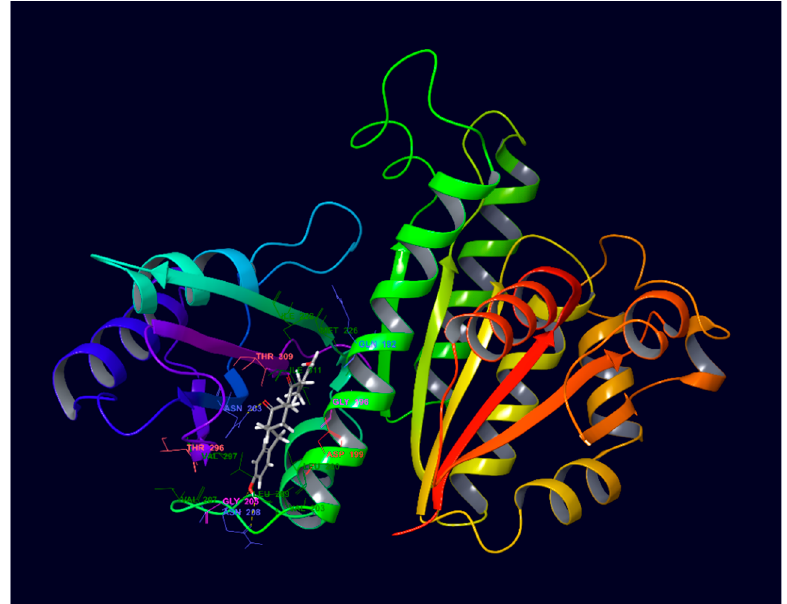
Figure 9. Compound 3 docked into PC190723 4 binding site on FtsZ (PDB ID: